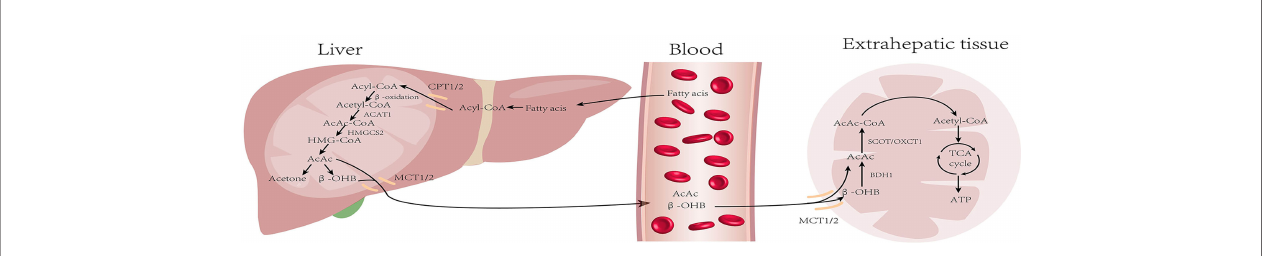
FIGURE 1 | Metabolism of ketone bodies: During starvation and prolonged exercise, lipid hydrolysis is enhanced and fatty acid production increases. First, fatty acids (FAs) are activated into acyl-CoA and then decomposed into acetyl-CoA through b -oxidation. Acetyl-CoA is converted into ketone bodies in mitochondria